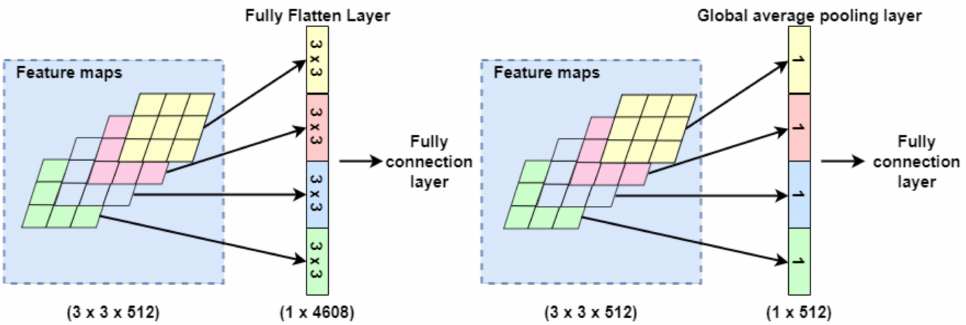
Figure 4. Fully flattened layer and global pooling layer.